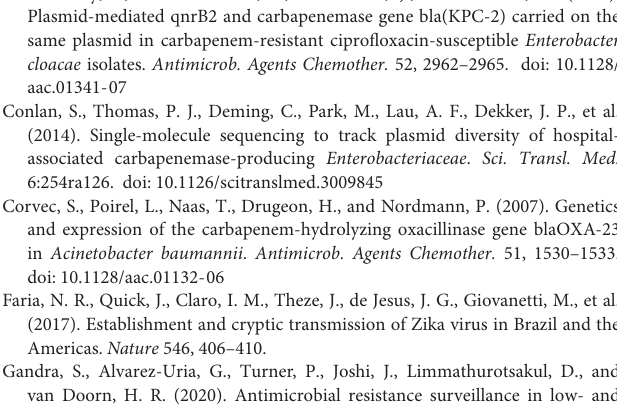
Supplementary Figure 1 | Bento Lab for on-site genomic epidemiological analysis of AMR bacteria in Cambodia. (A) The prototype used in this study and (B) current commercial type are shown. Supplementary Figure 2 | Multiple sequence alignment of carbapenemase genes analyzed by MAFFT v7.475. (A) Comparison between the bla NDM − 5 -like gene in E. coli pNIPH17_0020_1 (from on-site ONT analysis) and the reference gene ( bla NDM − 5 in accession no. JN104597), (B) comparison between the bla OXA − 181 -like gene in E. coli pNIPH17_0036_1 (from on-site ONT analysis) and the reference sequence ( bla OXA − 181 in accession no. CM004561), and (C) comparison between the bla OXA − 23 -like sequence in A. baumannii NIPH17_0019 (from on-site ONT analysis) and the reference sequence ( bla OXA − 23 in accession no. AY795964) are shown. Supplementary Figure 3 | Linear comparison of AbaR4-containing genomic regions in A. baumannii NIPH17_0019 harboring two copies of bla OXA − 23 . Two sets of AbaR4 with bla OXA − 23 in A. baumannii NIPH17_0019: (A) 216,633– 233,441 nt region inserted within comM and (B) 3,924,674–3,941,483 nt region inserted within mutY in accession no. AP024415, and (A,B) comparison of both the uncorrected sequences (from on-site ONT analysis) and corrected sequences (from subsequent ONT + Illumina analysis) are shown. Red, blue, black, and gray arrows indicate carbapenemase gene ( bla OXA − 23 ), mobile gene elements (MGE), pseudogenes disrupted by AbaR4 insertion (Pseudo), and other genes (Others), respectively. The colors in comparison of sequences show percent identity. Supplementary Table 1 | Summary of whole-genome sequencing and bioinformatics analysis of AMR bacteria isolated in Cambodia in this study. Bacterial isolates, nucleotides of raw reads of MinION sequencing and the corrected reads, genome size of the uncorrected sequence (from on-site ONT analysis) and corrected sequence (from subsequent ONT + Illumina analysis) are shown. Also, AMR genes (ARG) associated with resistance to β -lactams, aminoglycosides (AG), and fluoroquinolones (FQ), virulence genes, and accession nos. of sequences are